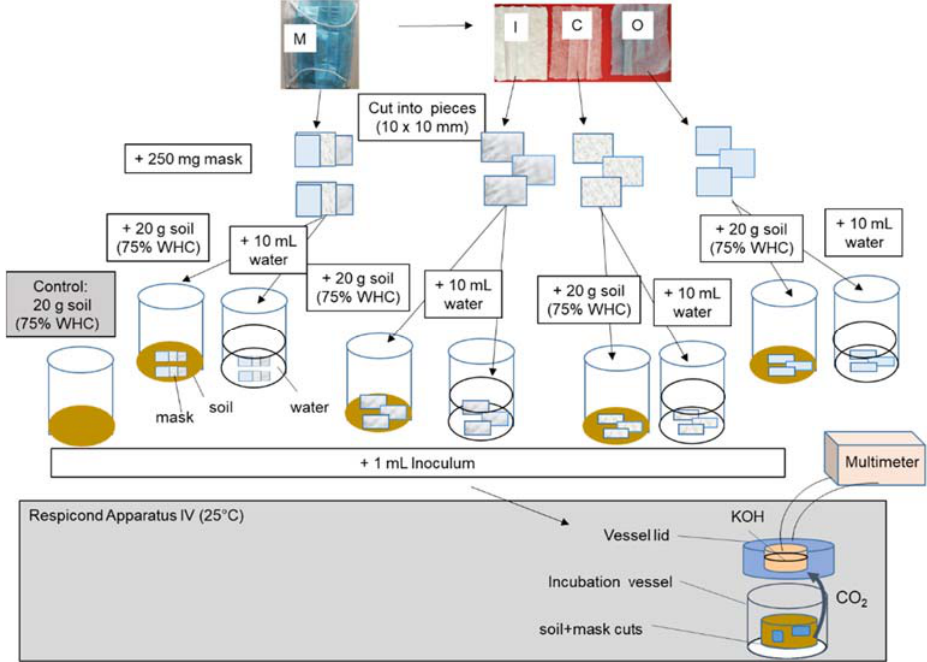
Figure 2. Scheme of the experimental design of the microcosm experiment for the study of the microbial degradation of surgical face mask residues in a soil environment. As a control, only soil was incubated after inoculation at 75% WHC.